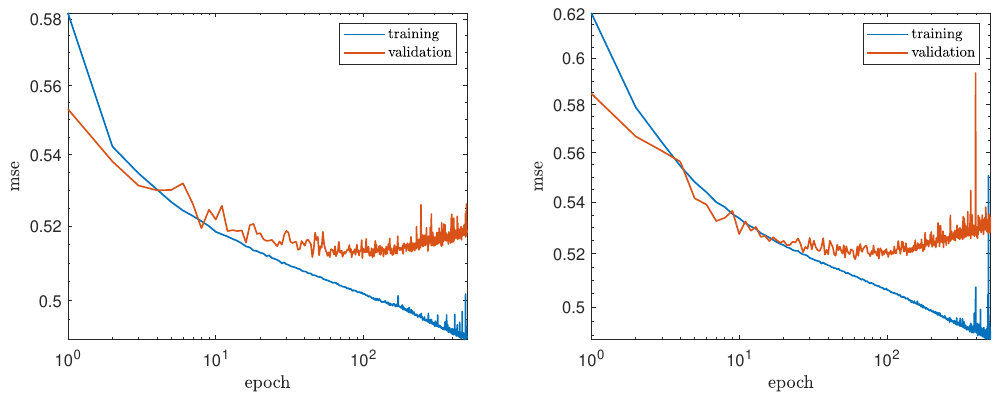
Figure 4 . The learning curves of the ANNs trained for W score , corresponding to O M and O T (right i